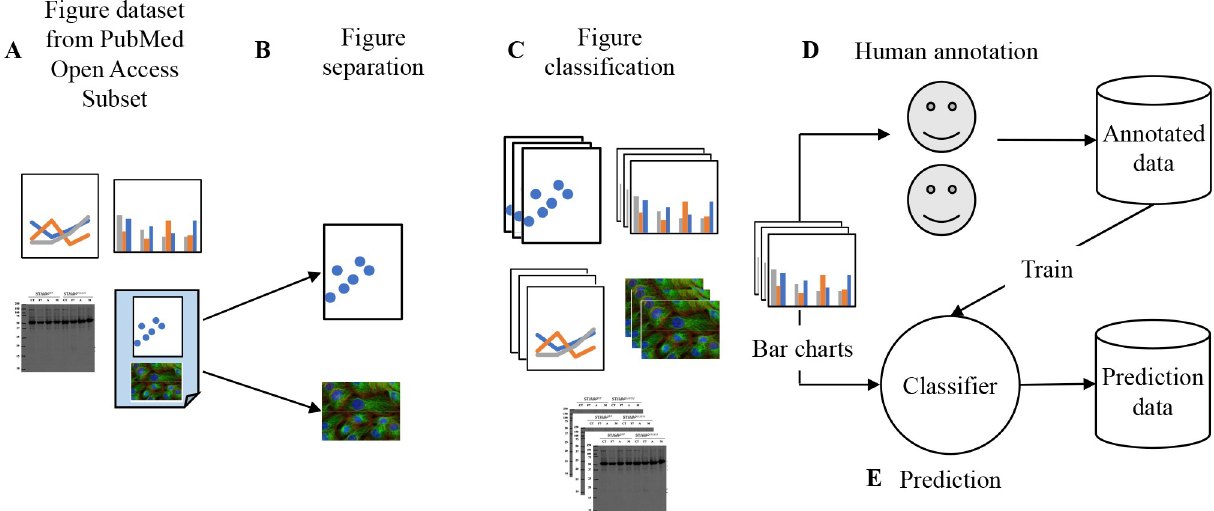
Fig 1. Process for labeling and predicting violations of the proportional ink principle in bar charts. A. Figures from the PubMed Open Access Subset (PMOAS) dataset are the source data. See Materials and Methods for details to (B) separate figures if they are compounded and (C) classify them into different kinds of charts. D. A large sample of bar charts are annotated by humans. E. These annotations are used to train a classifier and predict a large number of bar charts.